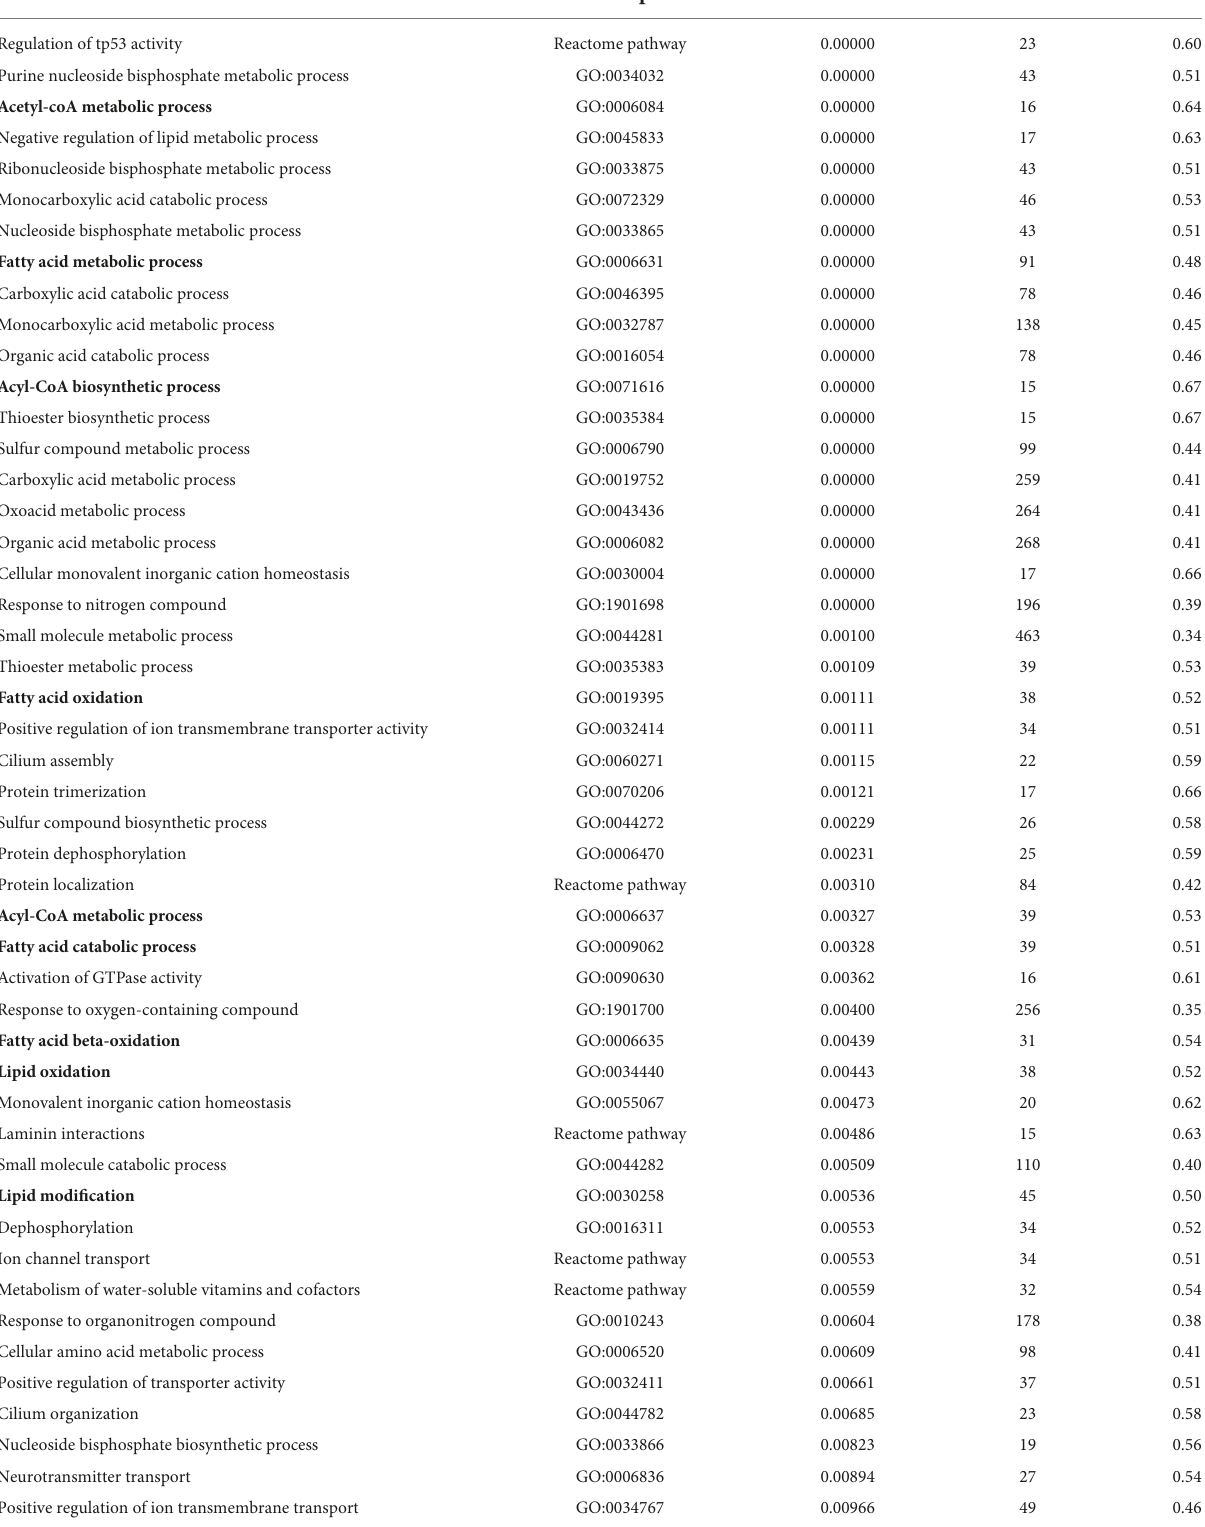
TABLE 3 Biological annotations terms significantly enriched in down-regulated proteins of the proteome